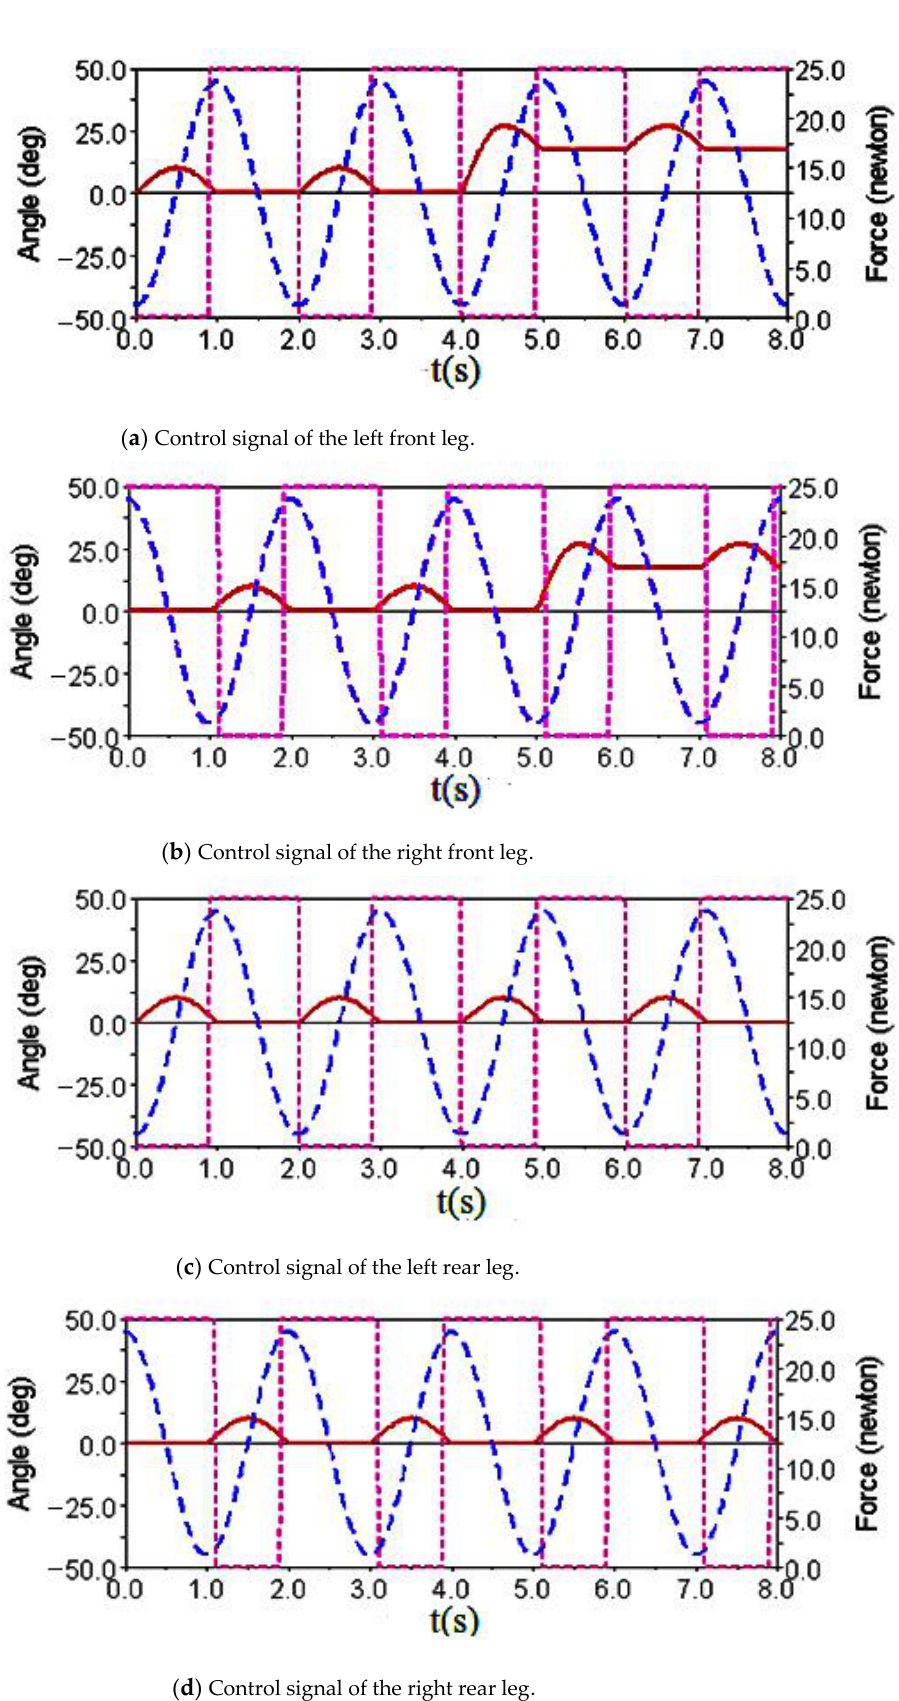
Figure 13. Robot leg control signals for the diagonal gait with the climbing step.